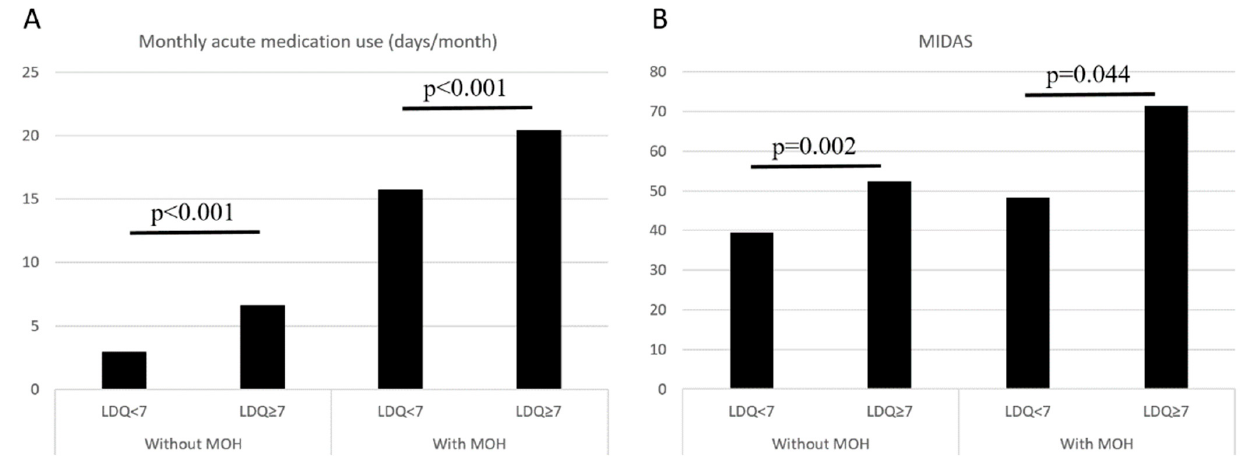
Figure 3. Comparisons on monthly acute medication use ( A ) and MIDAS scores ( B ) between patients with LDQ < 7 and LDQ ≥ 7 stratified by the presence of MOH. Abbreviations: LDQ = Leeds Dependence Questionnaire, MIDAS = Migraine Disability Assessment Scale, MOH = medication- overuse headache.